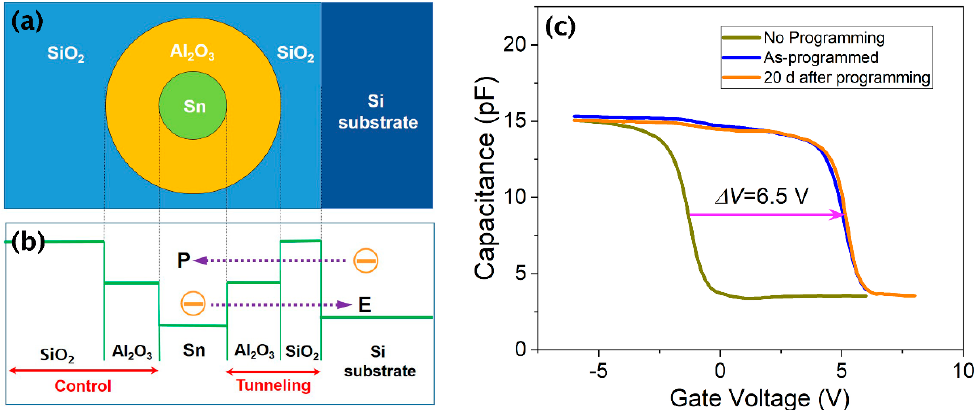
Figure 4. ( a ) Cross-sectional schematic representation of an Sn@Al 2 O 3 core-shell nanoparticle embedded between tunneling and control SiO 2 layers; ( b ) the band diagram associated with the core-shell structure shown in ( a ); and ( c ) Capacitance-voltage (C-V) curves over time after charging a Sn@Al 2 O 3 core-shell NP floating gate. No shift in the C-V curve is observed 20 d after charging. From the C-V data, we initially estimated the number ( n ) of electrons stored on a single Sn NC (cid:1843) (cid:2930) , where ∆(cid:1848) is the voltage shift of the C-V curve upon using the simple formula ∆(cid:1848) = (cid:3031) (cid:3084) (cid:3173)(cid:3177) application of a charge Q t , which in turn is the total charge stored in the NP floating gate corresponding to the area of the gate electrode ( A ). In addition, d is the distance between the NC floating gate and the gate electrode, and ε os is the dielectric permittivity of SiO 2 [16]. Using ∆(cid:1848) = 6.5 V, A = 0.09 mm 2 , d = 35 nm, and an areal density of Sn NCs, 1.5 × 10 12 cm − 2 , which was estimated using the TEM image shown in Figure 2b, the value of n was found to be 2.6 × 10 3 . This value indicates that a large number of electrons were trapped on a single NC, a result expected from metal NCs [3]. In particular, the high multiple trapping of electrons renders it possible to realize multibit memory [17,18] for enhancement of data storage capacity. Thus, the charge storage stability of the presented Sn@Al 2 O 3 core-shell NP floating gate was explored by monitoring the shift of the C-V curve over time after electron charging on the floating gate. The C-V curve shifts in proportion to the amount of charge stored in the floating gate, and so loss of the charge tapped in the floating gate causes a shift in the C-V curve. In the present case, no shift was observed for the C-V curve even 20 d after an electron charging of 2.6 × 10 3 per NC (Figure 4c). This lack of shift in the C-V curve indicates that there is no loss of charge trapped in the floating gate, which in turn implies a significantly more stable charge storage. When no erasing voltage is applied, the electrons trapped in the floating gate can be de-trapped into Si by tunneling emission through the tunneling barrier (as indicated by the dotted line E). In the present case, the SiO 2 /Al 2 O 3 stacked layer acts as a tunneling barrier, where the equivalent oxide thickness [19] of the Al 2 O 3 layer was added to that of the SiO 2 layer. This increase in the thickness of the tunneling gate oxide layer results in a reduction in the electron tunneling emission rate as compared to the case of a single SiO 2 tunneling layer, and so significantly increases the charge retention time, i.e., the charge storage stability. On the other hand, the other memory characteristics, such as programming speed (as indicated by the dotted line P) [6,7], strongly depend on the thickness of the low- k dielectric (SiO 2 ) layer. Therefore, these memory characteristics have not been tested here, since it would be worthwhile to examine after optimizing the thickness of the SiO 2 layer. The full memory characteristics of this structure will be examined separately in future studies. 4. Conclusions In conclusion, we successfully developed a simple method to fabricate a Sn nanocrystal floating gate with a SiO 2 /Al 2 O 3 dielectric stacked tunneling barrier that is suitable for highly functional NVM devices. This memory structure was easily formed through the preparation of Sn@Al 2 O 3 core-shell